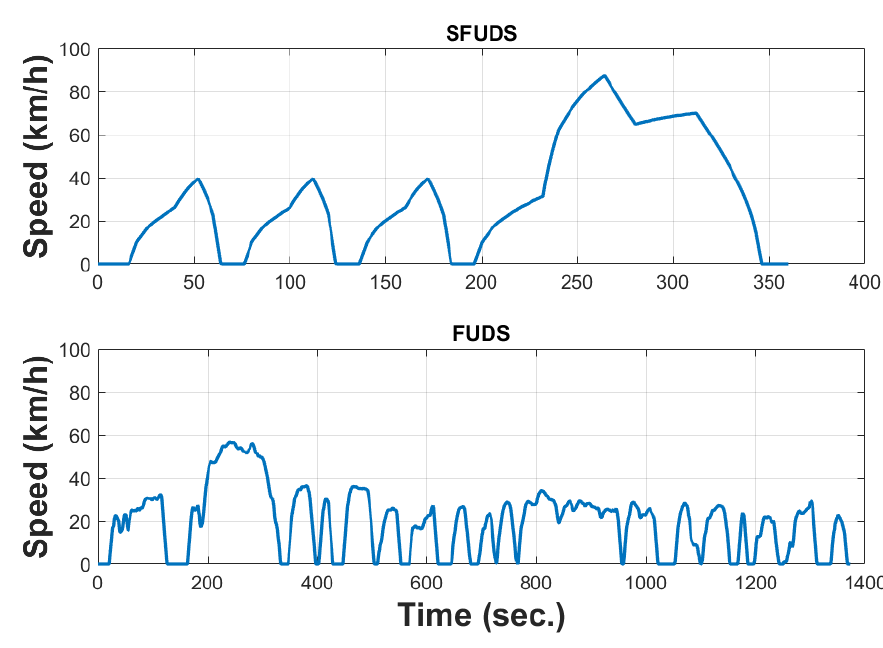
Figure 10. SFUDS (top) and FUDS (bottom).